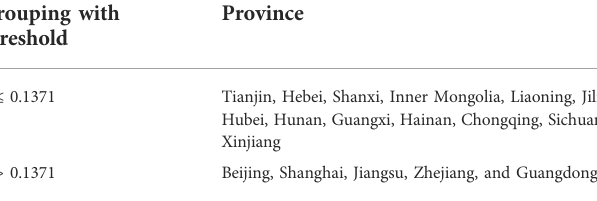
TABLE 5 Sample grouping based on threshold values (2016).